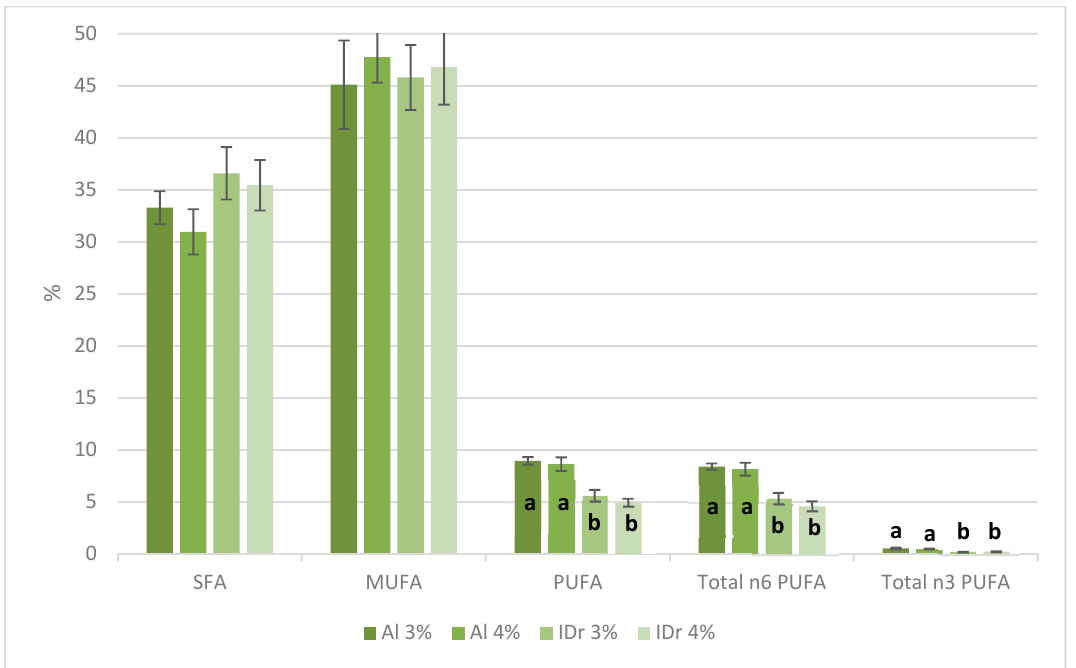
Figure 1. Catalão methyl ester fatty acid-derivatives (expressed in %), with PUFA content showing significant differences regarding genotype.